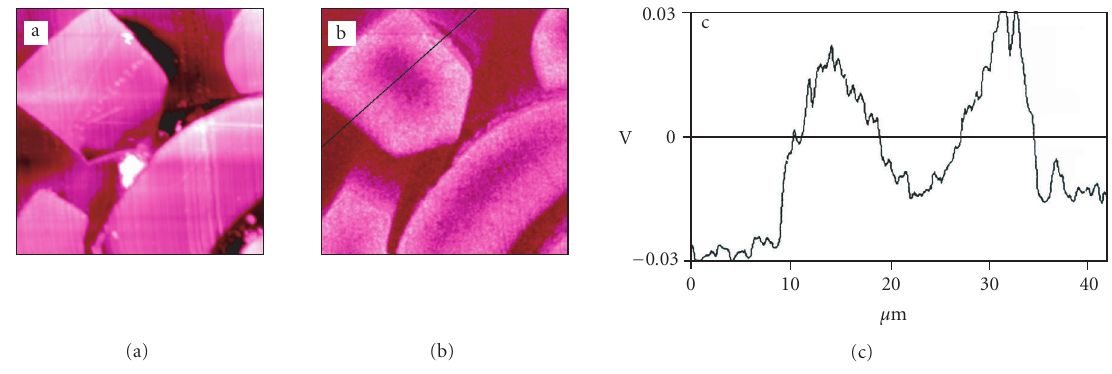
Figure 43: Simultaneous shear-force AFM (a) (50 μ m, Z range 1 μ m) and fluorescence SNOM (b) of a microtome cut surface of a polyester fiber (dye 13 ) embedded in Agar 100, showing ring dying in the optical contrast and the cross section (c) through the fluorescence intensity as indicated in (b).